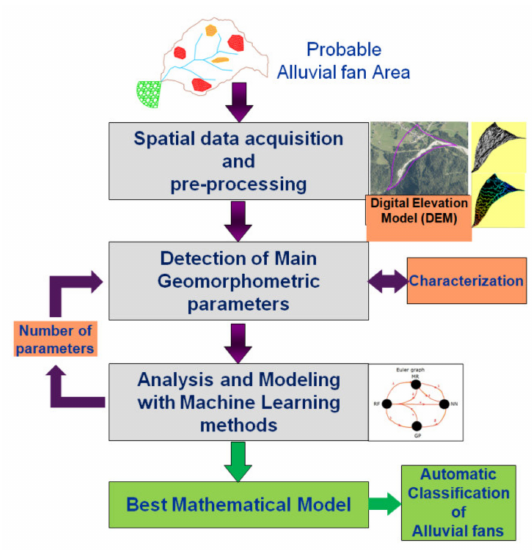
Figure 1. Schematic workflow of the